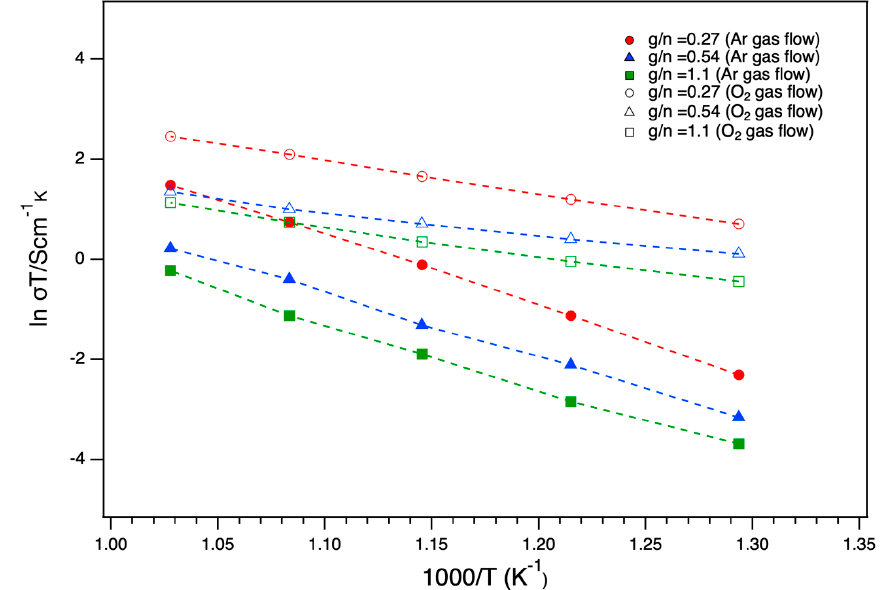
Figure 5. Arrhenius-type plot of the total conductivity at intermediate temperatures for NiO/ScSZ with different g/n ratios under Ar and O 2 gas flow environment from 500 °C to 700 °C.